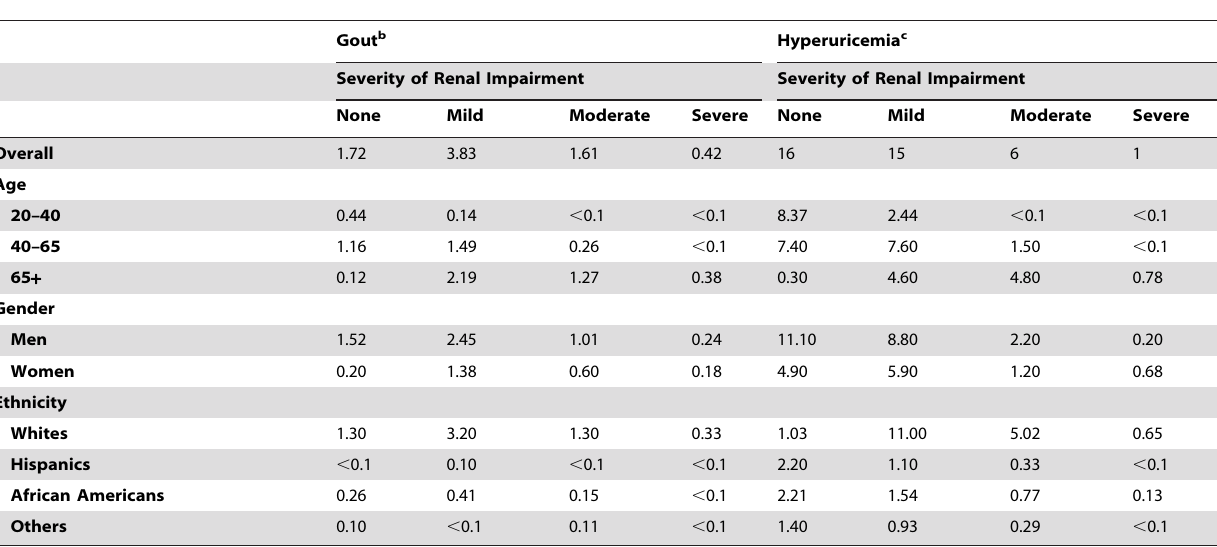
Table 2. Estimates of number of people with gout and hyperuricemia, in millions, by renal impairment status. a